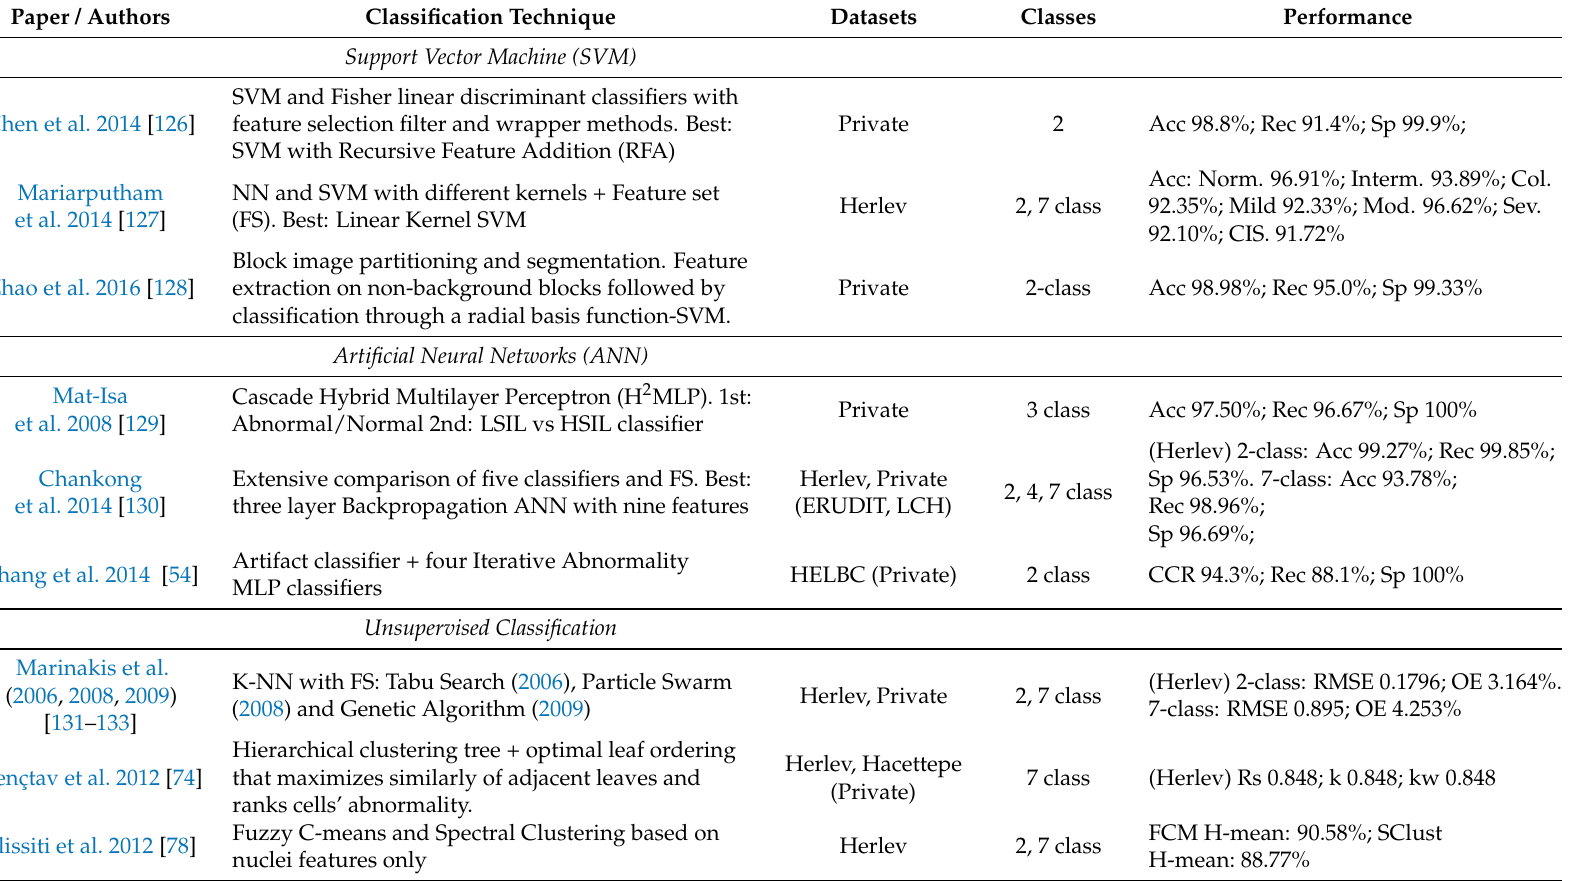
Table 4. Summary table with highlighted works on cervical cell classification. When more than one dataset was used, performance is given only on the public datasets for comparison purposes. Extension works presented by the same author/group are in the same line. In this case, performance is given for the best case, which is the most recent work. Acc (Accuracy), Prec (Precision), Rec (Recall), Sp (Specificity), H-mean (Harmonic mean of Sensitivity and Specificity), CCR (Correct Classification Rate), Rs (Spearman rank-order correlation coefficient), k (Cohen’s kappa coefficient), kw (weighted kappa coefficient), RMSE (Root Mean Square Error), OE (Overall